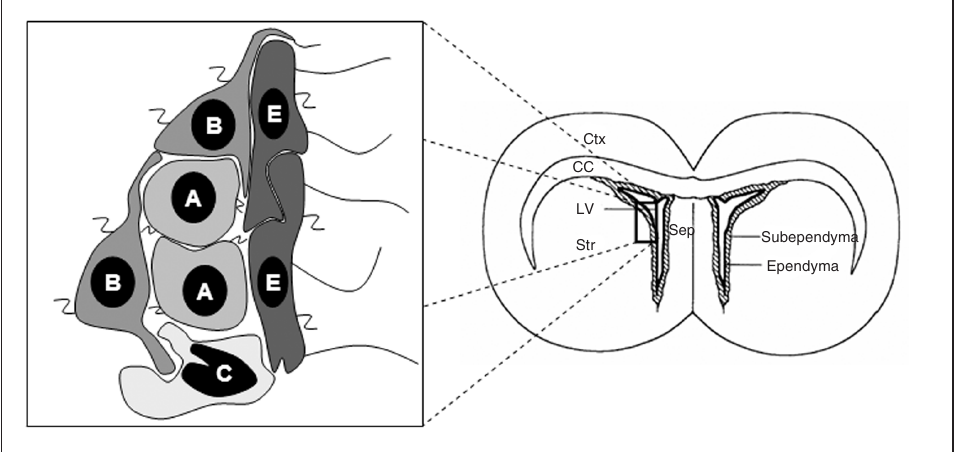
Figure 1. Schematic diagram of the organization of the adult subventricular zone. Migrating neuroblasts (type A cells) are surrounded by astrocytes (type B cells) that separate the migrating cells from the striatum. The type B cells eventually possess a single cilium that touches the ventricular lumen, are self-renewable and express glial fibrillary acid protein (GFAP). Ependymal cells (type E cells) line the ventricular surface and possess functional cilia. In close association with the neuroblasts are the C cells. The type C cells are putative intermediate precursors that give rise to the migrating neuroblasts and are self-renewable as well. Two different views in the literature point to type B and type E cells as good candidates for the true adult neural stem cell identity (29,31). Note that both of them express the ganglioside 9-O-acetyl GD3 ( z ) in their membranes. Therefore, this ganglioside can be used as a surface marker to isolate an enriched population of adult neural stem cells. Since type A cells also express the ganglioside 9-O-acetyl GD3 this antigen could not be considered an exclusive marker of adult neural stem cells. A = type A cells; B = type B cells; C = type C cells; E = type E cells; Ctx = cerebral cortex; CC = corpus callosum; LV = lateral ventricle; Sep = septum; Str =